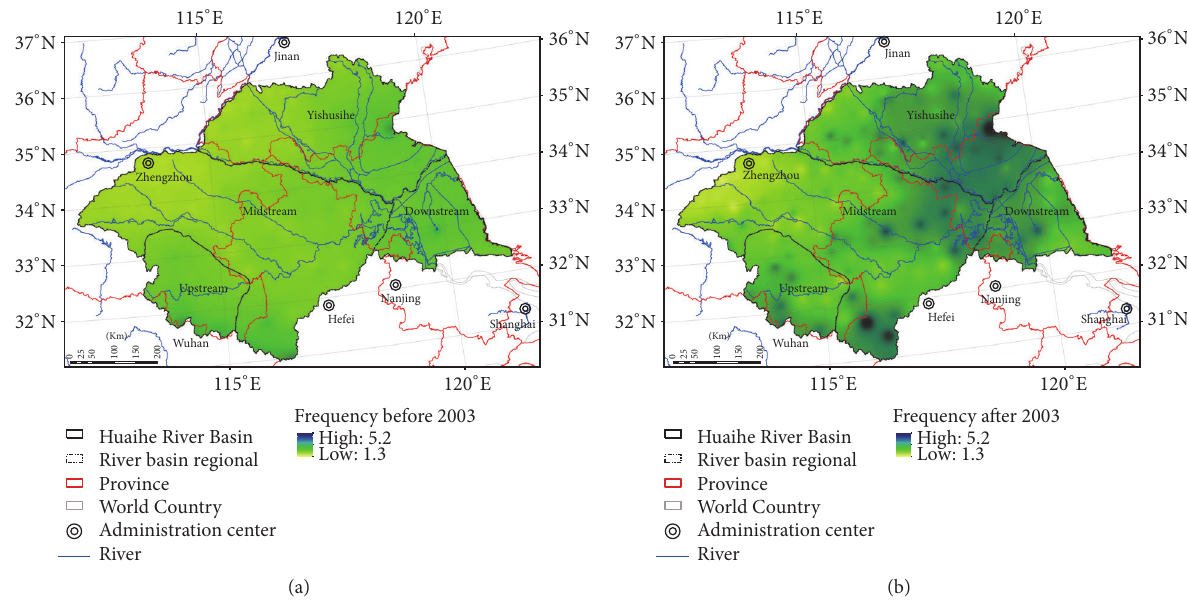
Figure 15: Spatial distribution of isolated rainstorm event frequency, before and after mutation